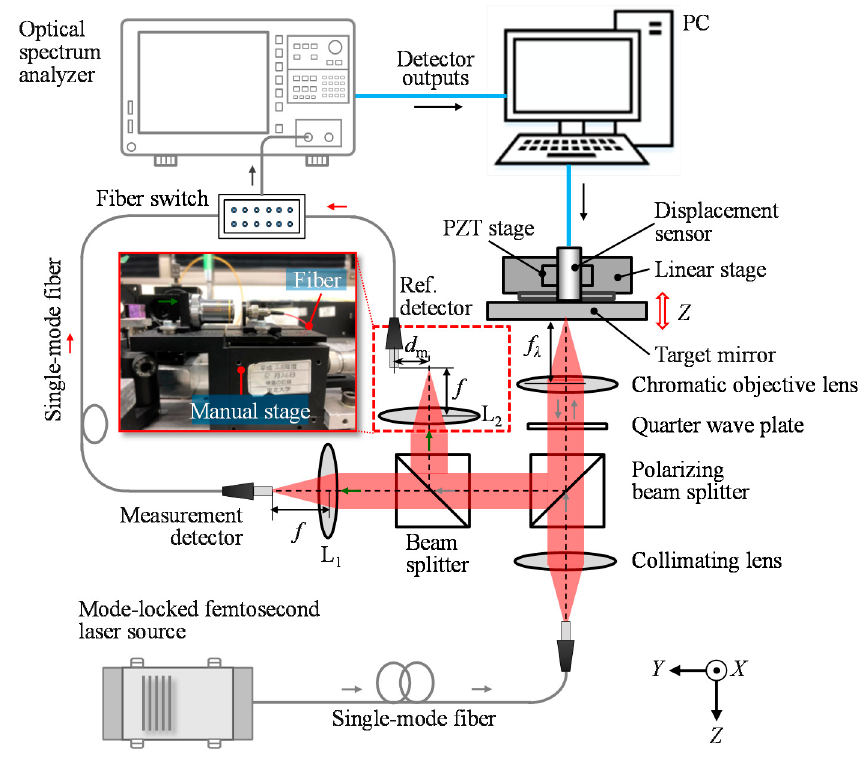
Figure 6. A schematic diagram of the proposed off-axis differential chromatic confocal probe configuration with a mode-locked femtosecond laser source [30].